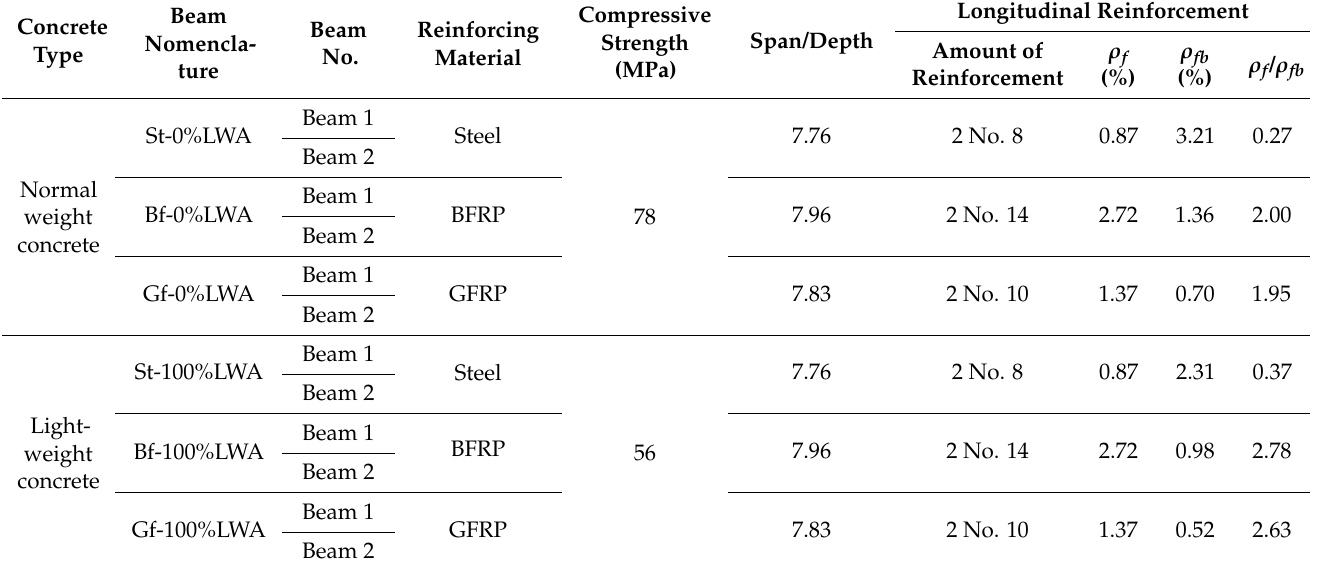
Table 6. Details of test